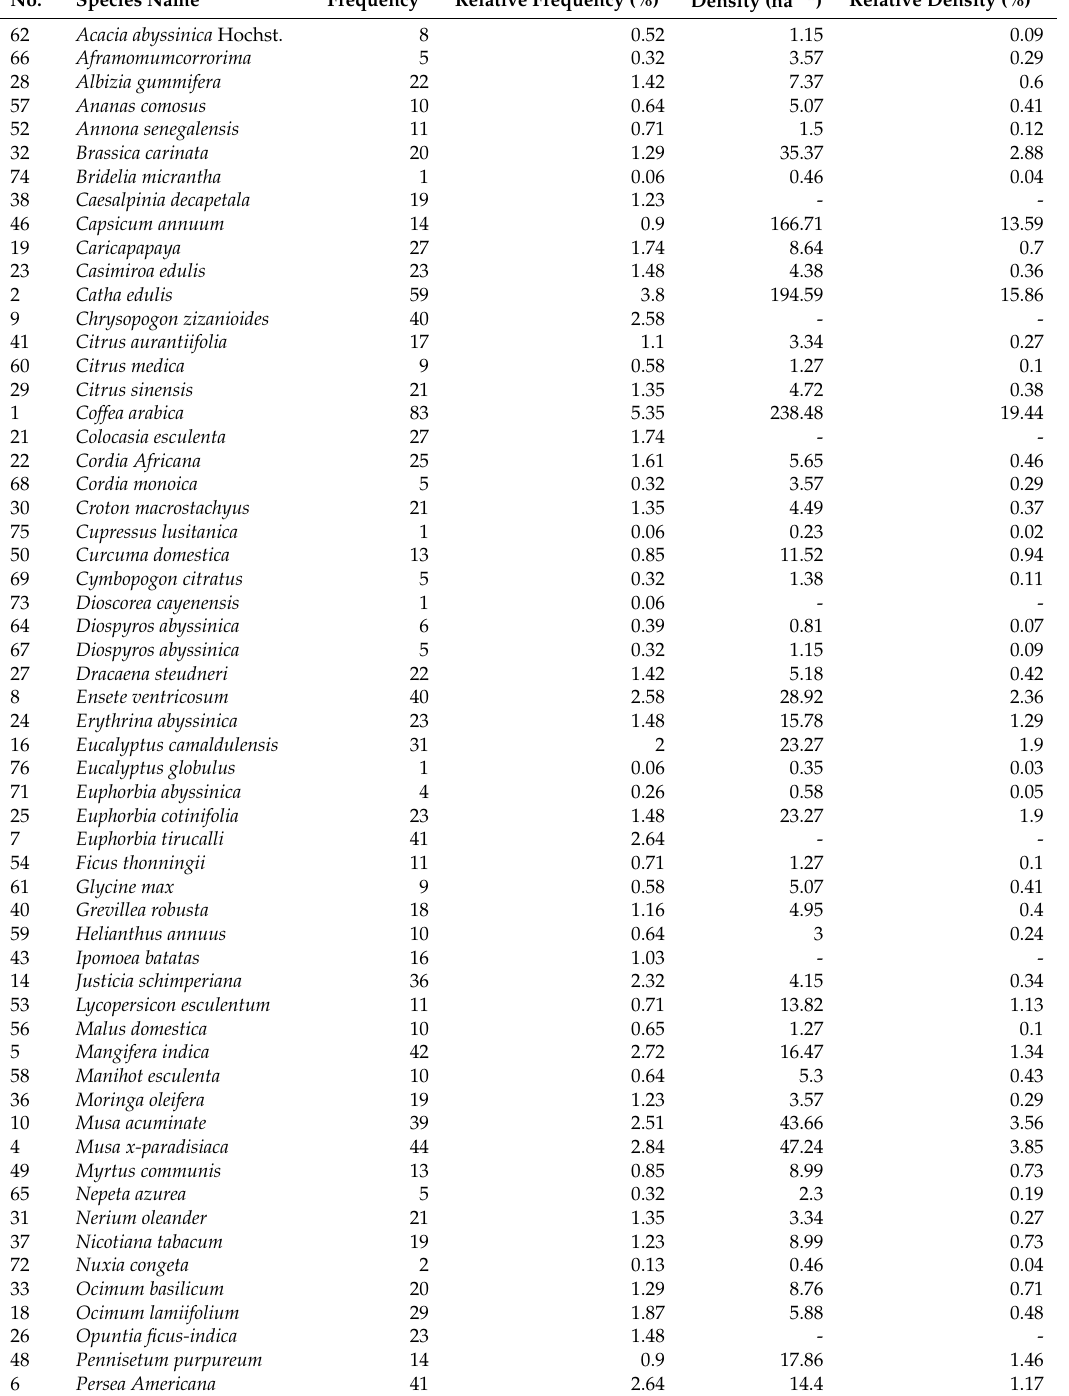
Table A2. Species frequency, relative frequency, density, and relative